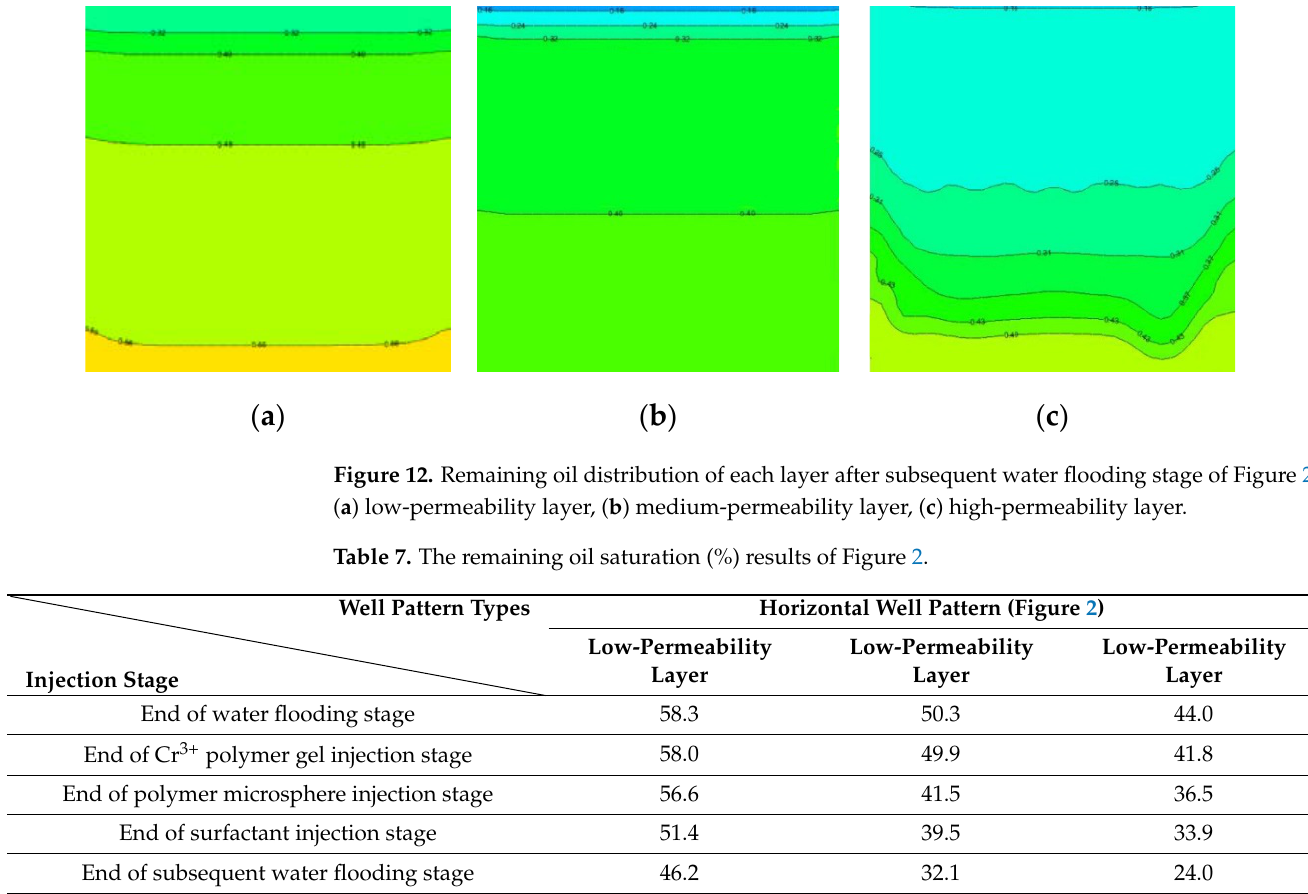
Figure 11. Remaining oil distribution of each layer after water flooding stage of Figure 2: ( a ) low-